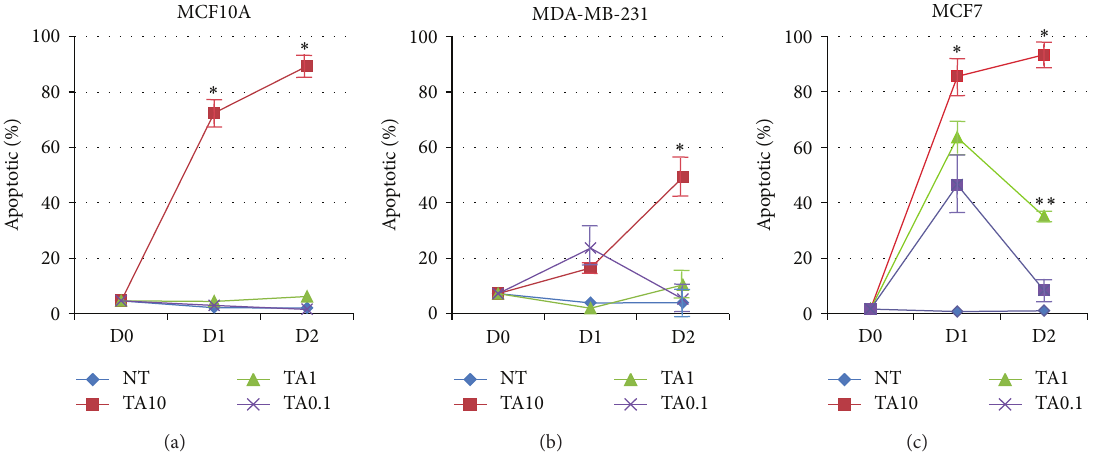
Figure 4: Tannic acid exposure induces apoptosis in breast cells. (a) MCF10A, (b) MDA-MB-231, and (c) MCF7 cells were untreated or treated with 10%, 1.0%, and 0.1% TA cross-linked beads for 24–48 h. TUNEL assays were performed and the results displayed as the percentage of apoptotic cells. 𝑛 = 3 , ∗ 𝑃 < 0.05 versus ∗∗ 𝑃 < 0.05 and error bars=SE. NT: no